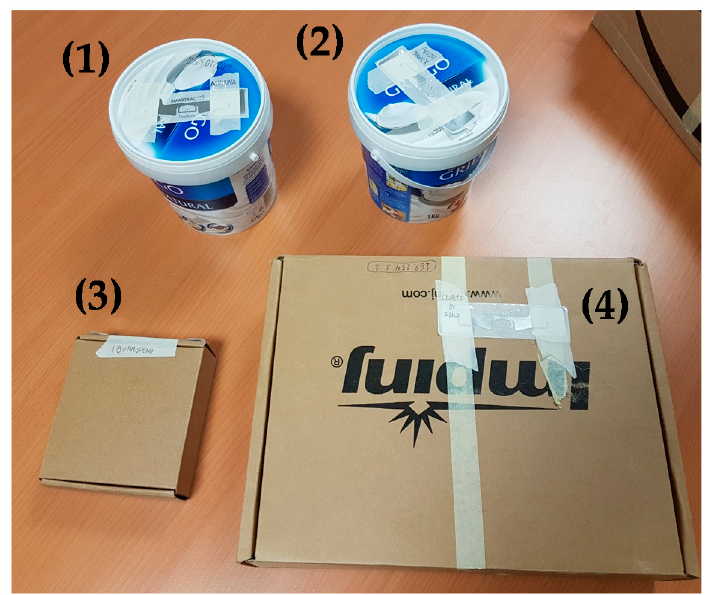
Figure 10. Examples of items tagged with passive DogBone RFID tags [31], emulating medical assets and drugs containers: (1) aspirin, (2) tranexamic acid, (3) ibuprofen, (4) sodium chlorate.